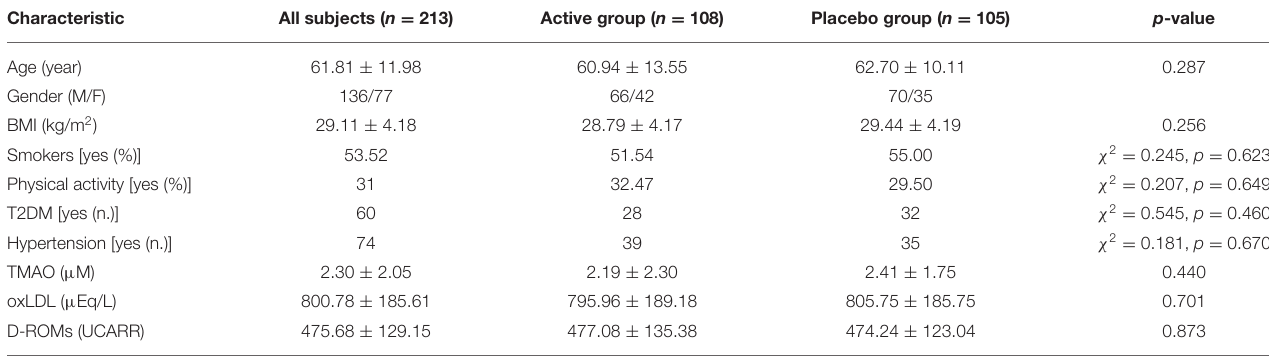
TABLE 1 | Baseline characteristics of study participants.